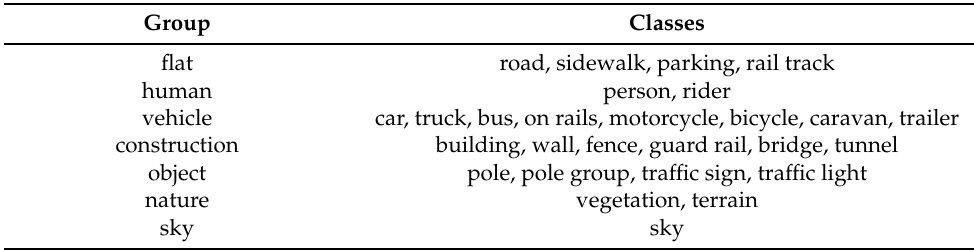
Table 2. Classes from the Cityscapes